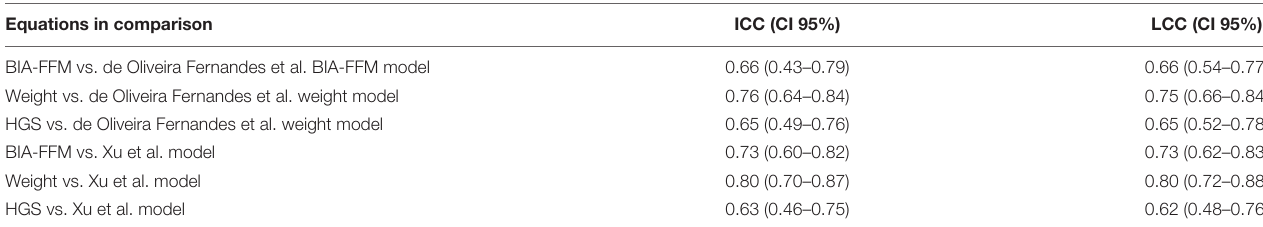
TABLE 4 | The intraclass correlation coefficient between previously validated equations, as a standard reference, and our models ( n = 71). Equations in